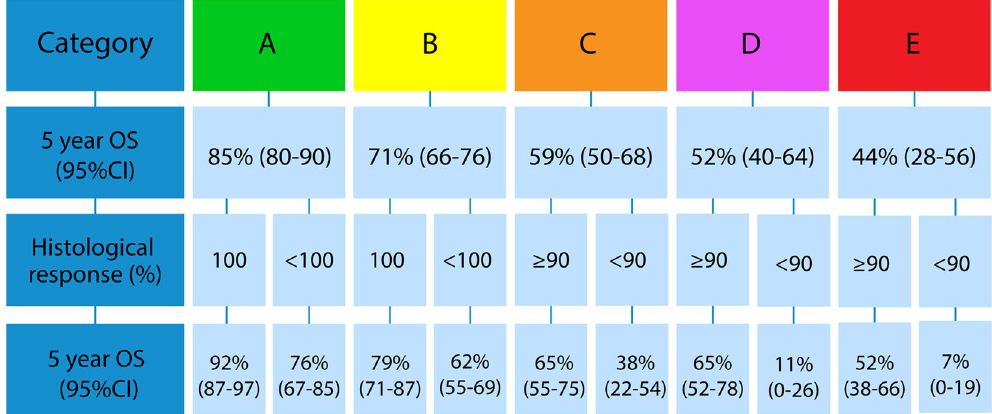
Figure 4. Flowchart for stratification of Ewing sarcoma patients at surgery assessed by Kaplan Meier